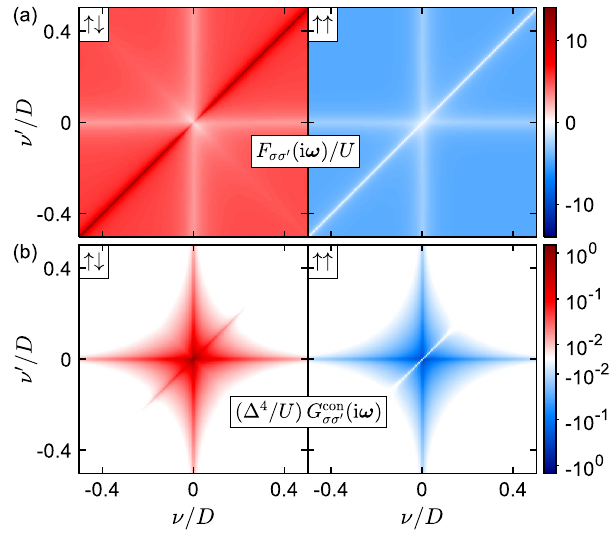
FIG. 4. (a) MF 4 p vertex F σσ 0 ð i ω Þ =U , and (b) MF connected 4 p correlator ð Δ 4 =U Þ G con σσ ð i ω Þ , for the strongly interacting AIM 0 ( U= Δ ¼ 5 , Δ =D ¼ 1 = 25 , T=D ¼ 10 − 4 ), as a function of ν and ν 0 at ω ¼ 0 . The left (right) panels show σ ≠ σ 0 ( σ ¼ σ 0 ).